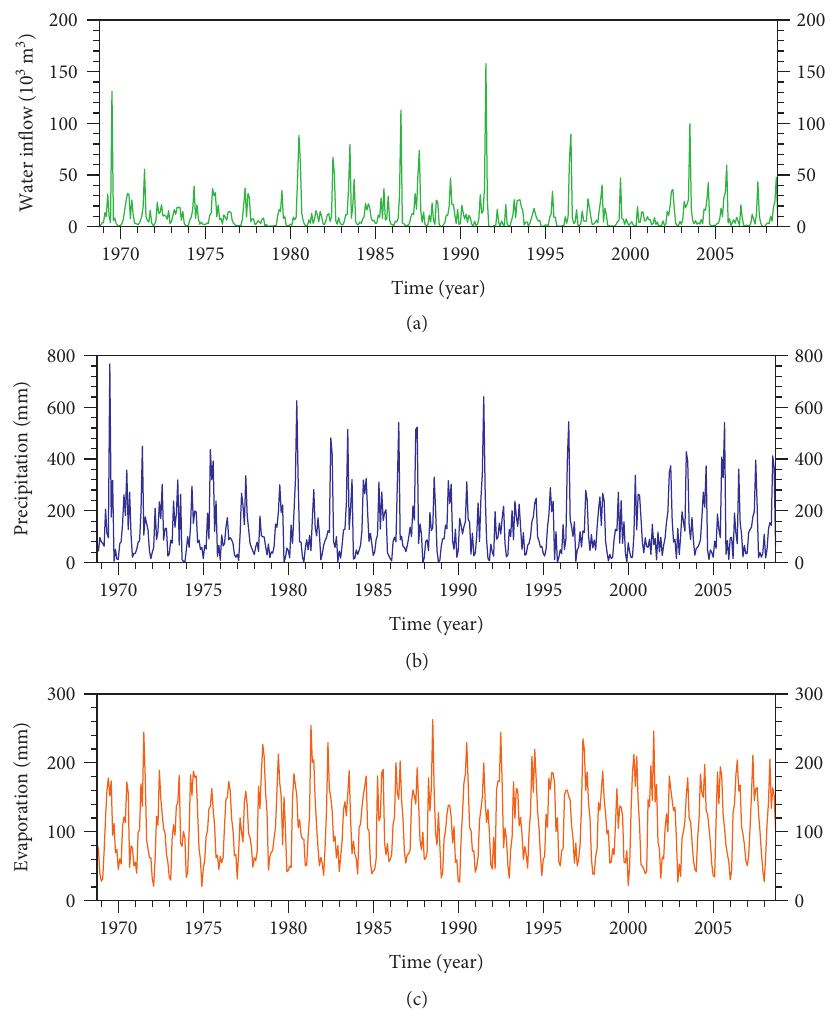
Figure 2: Monthly (a) water inflow, (b) precipitation, and (c) evaporation at Meishan